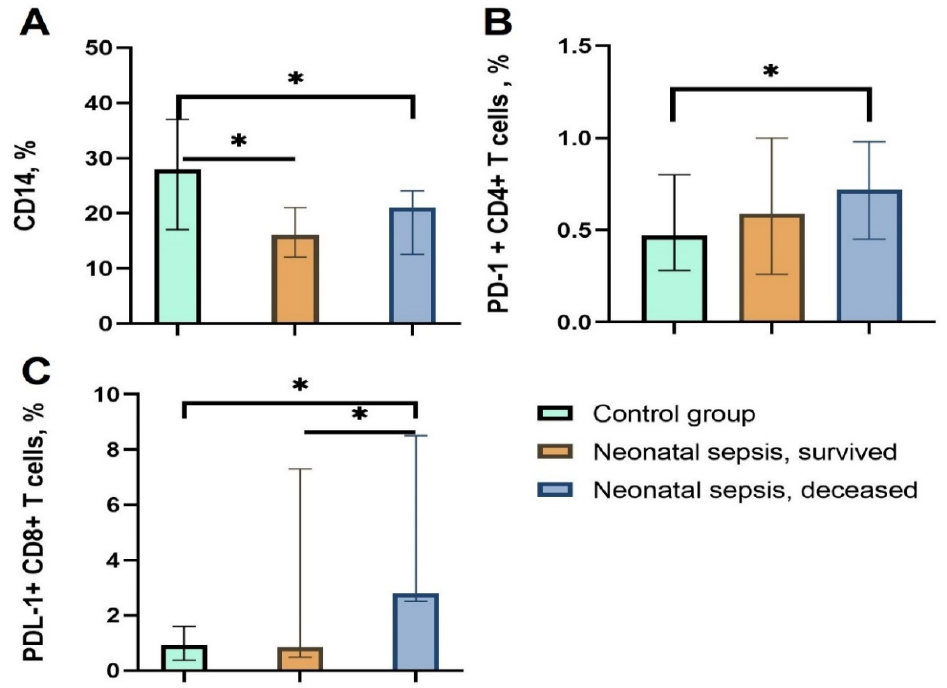
Figure 1. The expression level of functional markers of blood cells in newborns hospitalized with sepsis in three groups. ( A ) The percentage of expression of CD14 on monocytes; ( B ) the percentage of expression of PD-1 on CD4 + T cells; ( C ) the percentage of expression of PDL-1 on CD8 + T cells; * p <